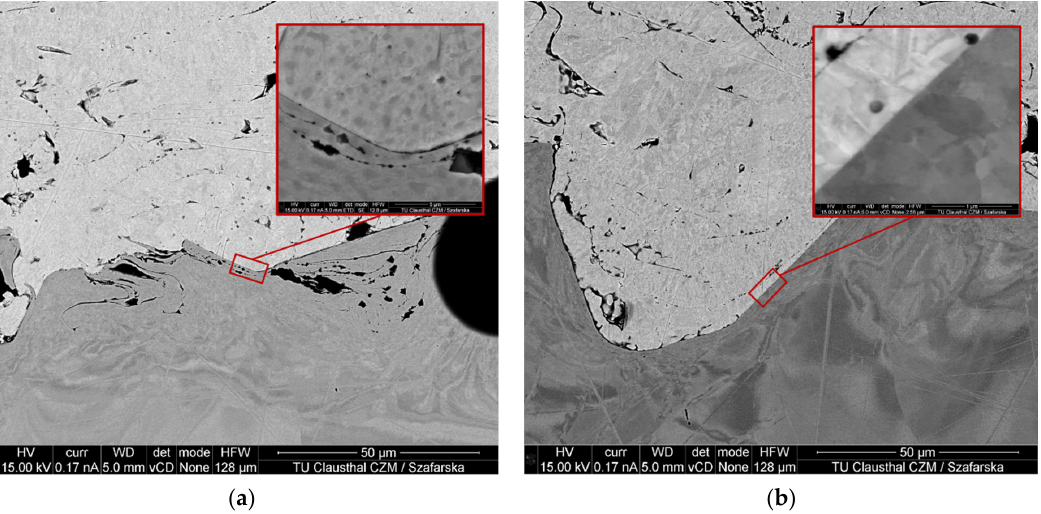
Figure 5. SEM micrographs of cross sections from samples coated with copper in silane ‐ doped nitrogen, which were blasted: ( a ) in air and ( b ) in the XHV ‐ adequate environment.